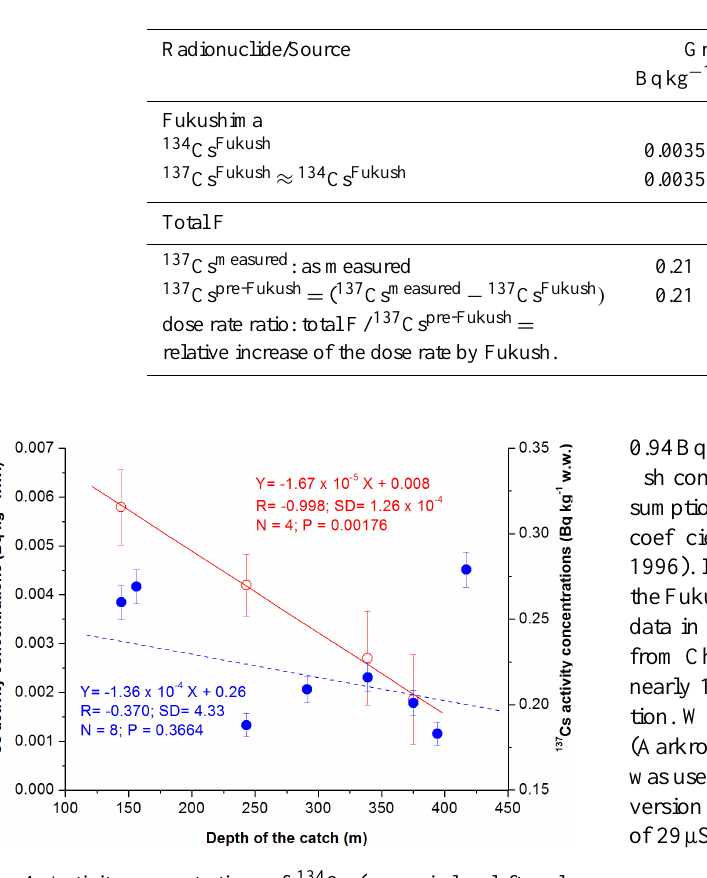
Fig. 4. Activity concentrations of 134 Cs (open circles, left scale, 2011) and of 137 Cs (closed circles, right scale, 2010 + 2011) in fish fillets plotted versus sampling depth; measurement uncertain- ties given are ± 1 σ ; Note: the smallest of the 134 Cs values repre- sents a “non-detect” with DL of 0.0032, for which a replacement value was